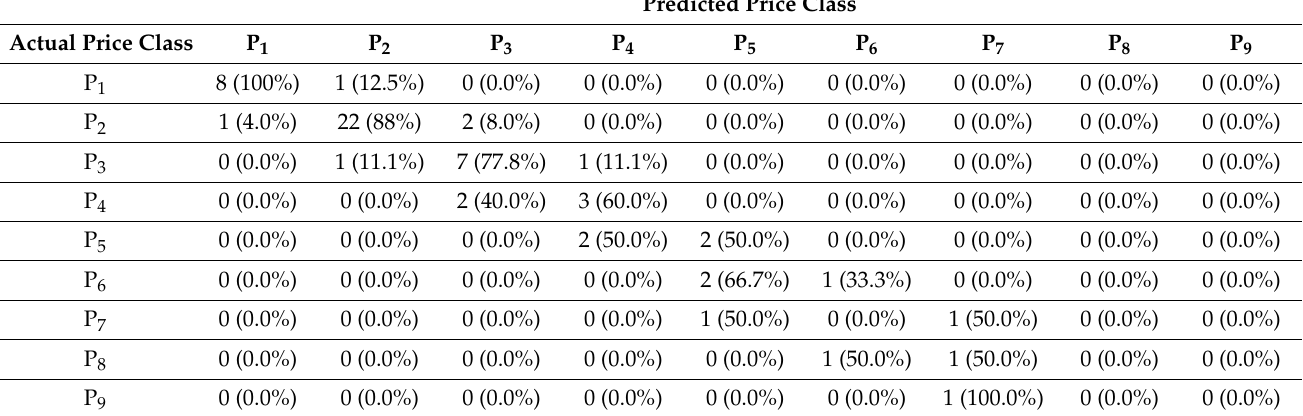
Table 7. Confusion matrix output for the logs’ price data per cubic metre from the ANN model, with numbers and percentages of classified spruce